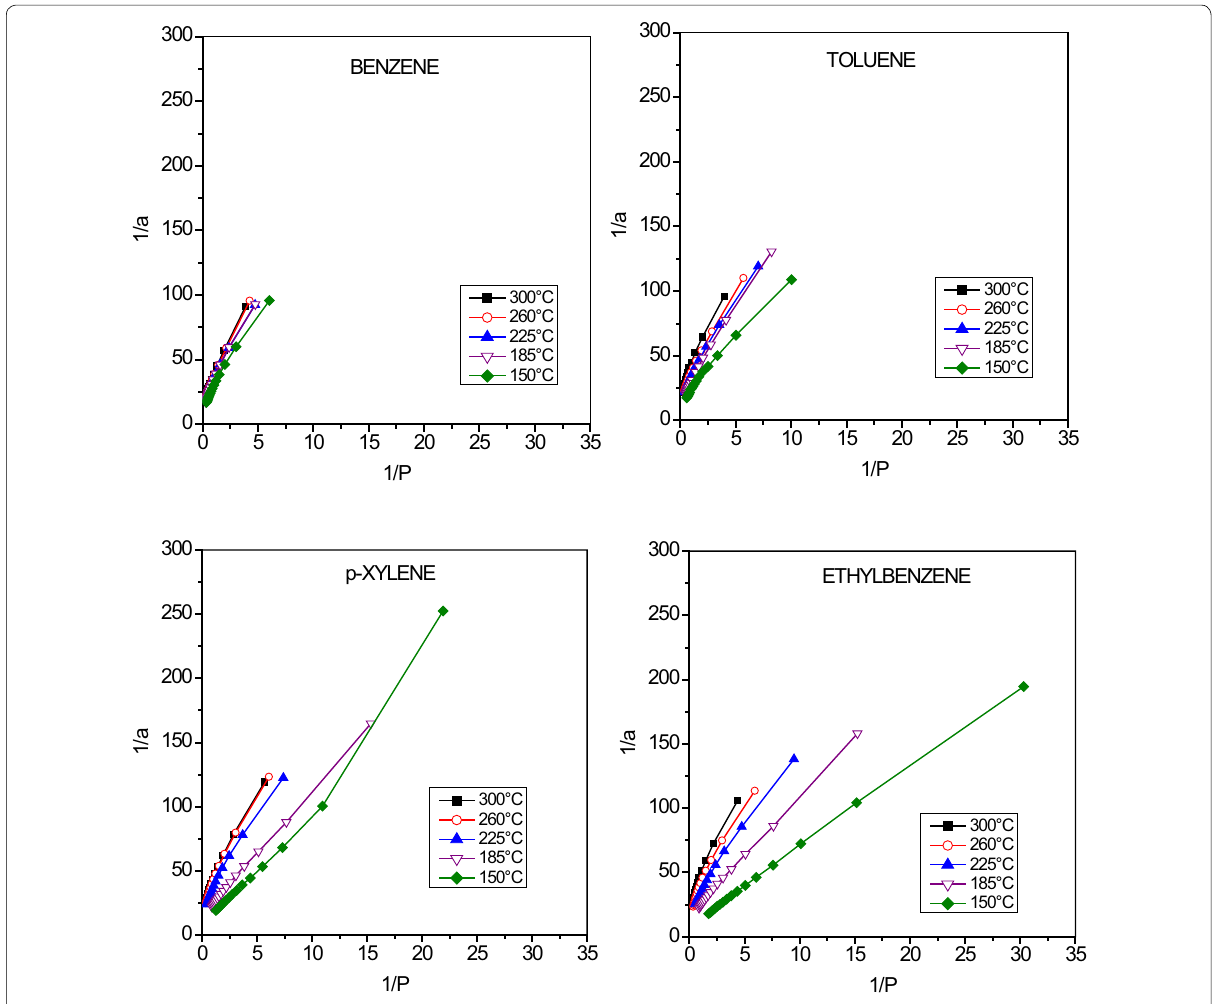
Fig. 9 Benzene, toluene, p ‑xylene, and ethylbenzene adsorption isotherms with the Langmuir model for